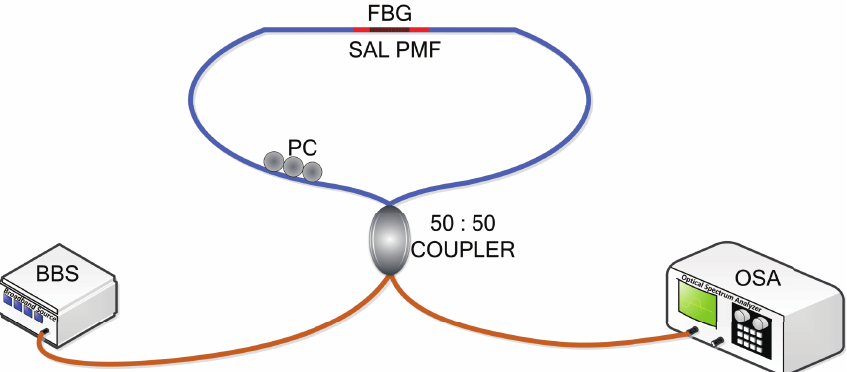
Figure 2. Schematic diagram of the proposed configuration and experimental setup. BBS: broadband source; OSA: optical spectrum analyzer; PC: polarization controller; FBG: fiber Bragg grating; SAL PMF: SiO 2 -Al 2 O 3 -La 2 O 3 polarization-maintaining